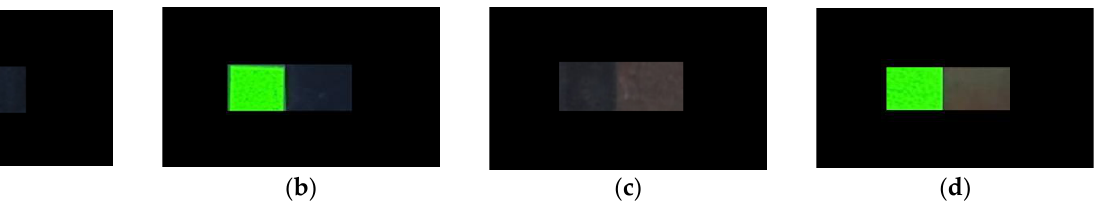
Figure 11. Fabrication and operation of polarized mode transparent OLED display is ( a ) when OLED and LCD are dark state, ( b ) when only OLED is bright state, ( c ) when only LCD is bright state, ( d ) when all is bright state.